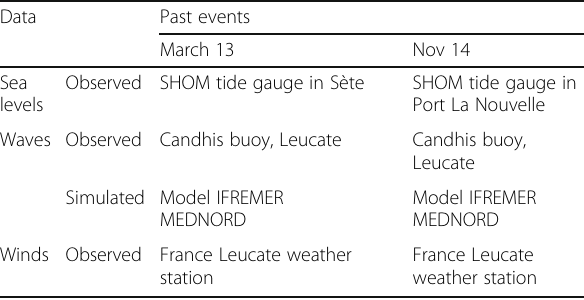
Table 1 Observed and simulated